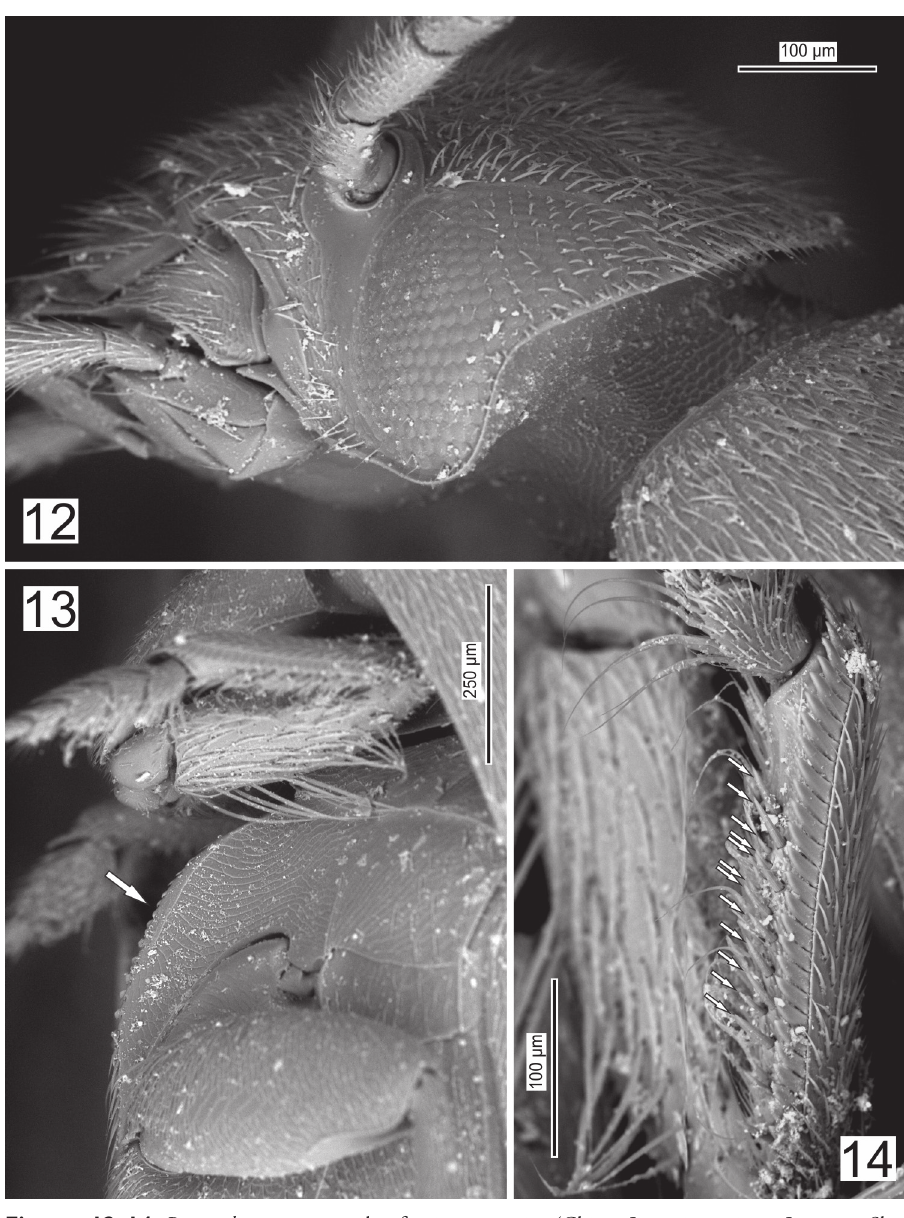
Figures 12–14. Ptomaphaginus sp., male of epigean species (China: Jiangxi province, Jinggang Shan Mts., Baiyinhu env., NMPC). 12 head in lateral view 13 mesoventral process in lateral view 14 left proti- bia in lateral view (arrows indicate position of spines on ventral